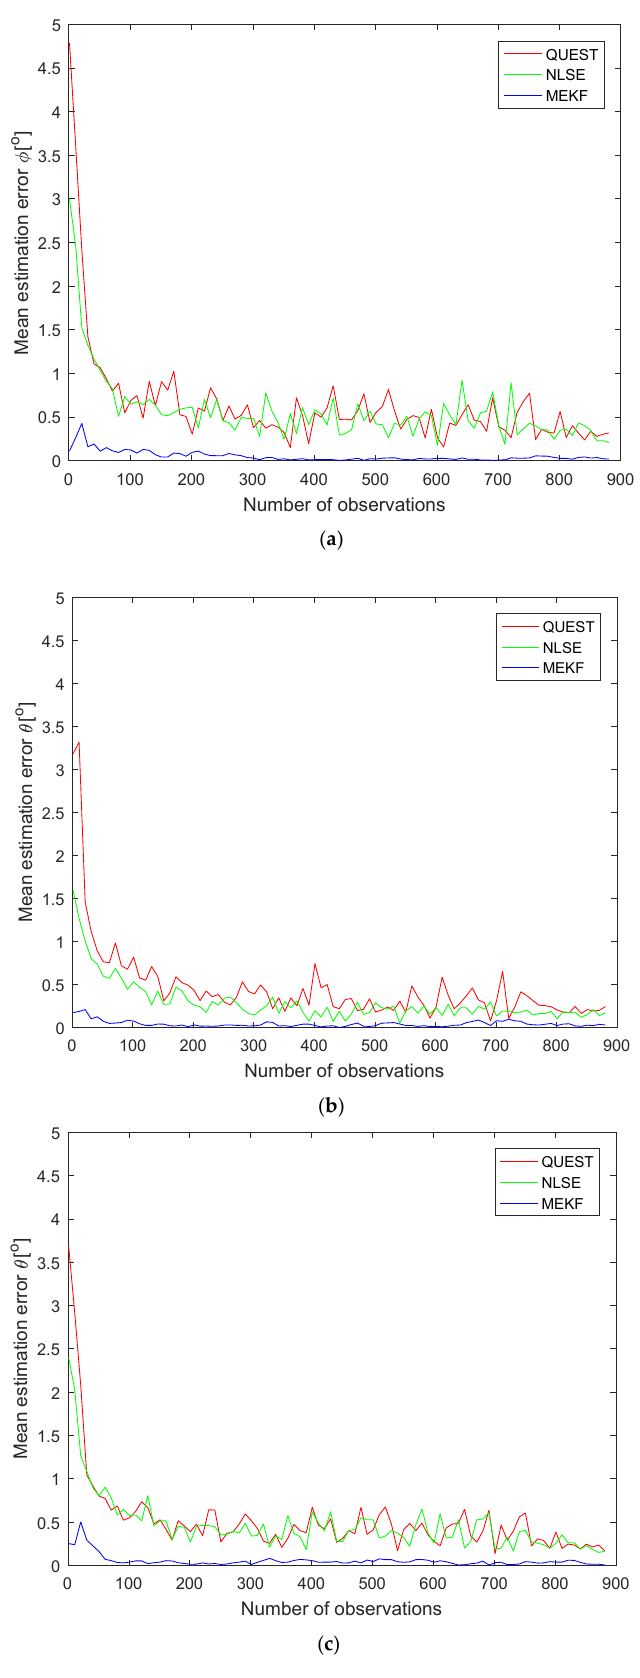
Figure 10. Mean estimation errors of φ ( a ), θ ( b ) and ψ ( c ) with respect to the number of observations.